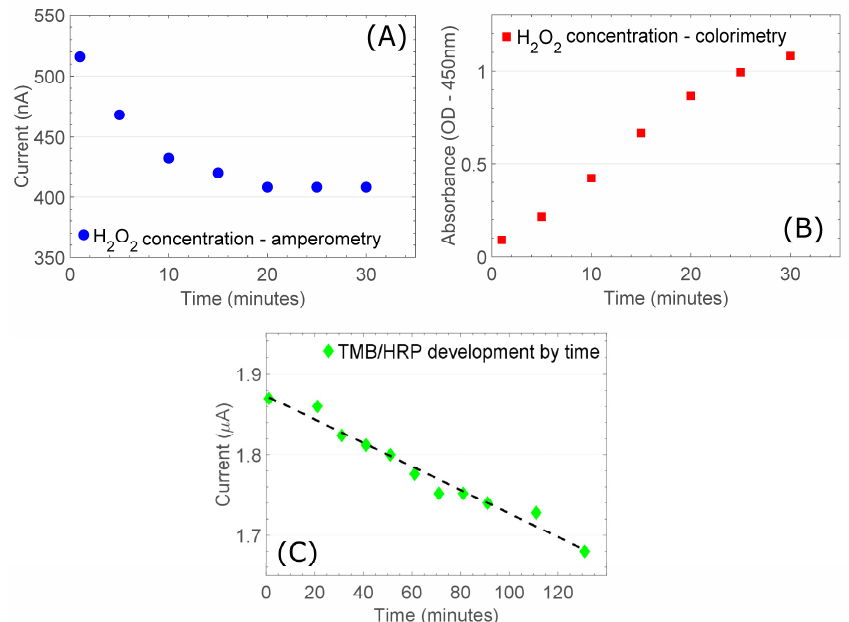
Figure 4. H 2 O 2 concentrations are measured by ( A ) amperometry and ( B ) colorimetry; ( C ) TMB conversion by low enzyme concentrations over an extended time period demonstrates a high level of sensitivity in the electrochemical detection technique.